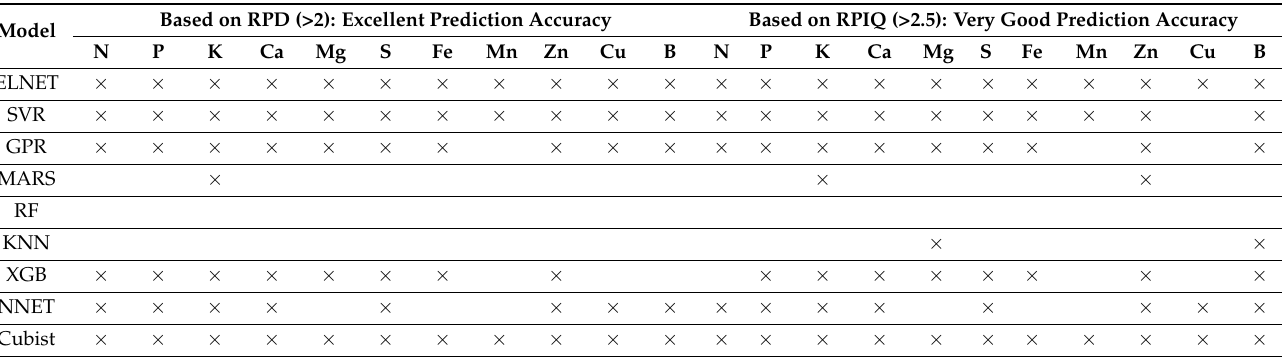
Table 5. Summarized independent validation performance of the machine learning models in combination with PLSR for predicting mango leaf nutrients based on RPD and RPIQ.